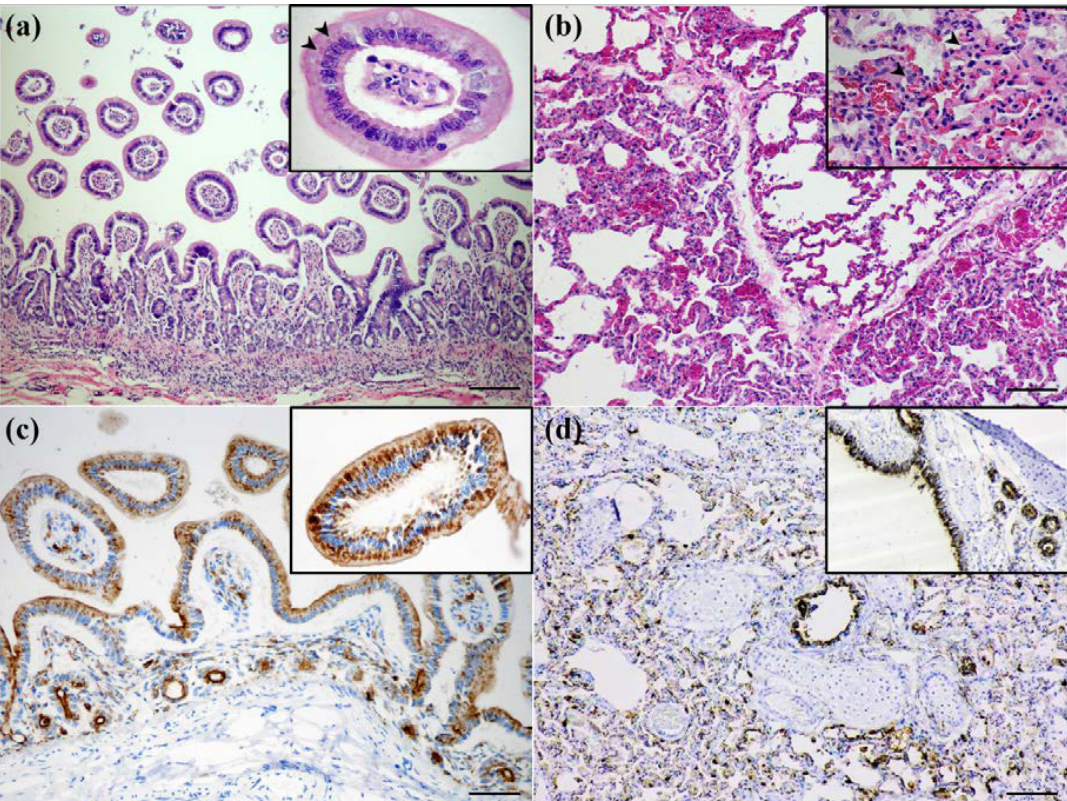
Figure 1. Civet tissue staining. ( a , b ); H&E staining showing ( a ) severe chronic lymphoplasmacytic enteritis with eosinophilic intranuclear and intracytoplasmic inclusion bodies that are frequently seen within villous epitheliums (inset, arrowheads) and ( b ) severe broncho-interstitial pneumonia with eosinophilic intracytoplasmic inclusion bodies that were randomly observed in pneumocyte-lining alveoli (inset, arrowheads). ( c , d ), IHC staining showing the immunopositive CDV antigen was diffusely observed within ( c ) cryptal and villous epitheliums (inset) and ( d ) in pulmonary and bronchial epitheliums (inset). Scale bar = 200 μm.